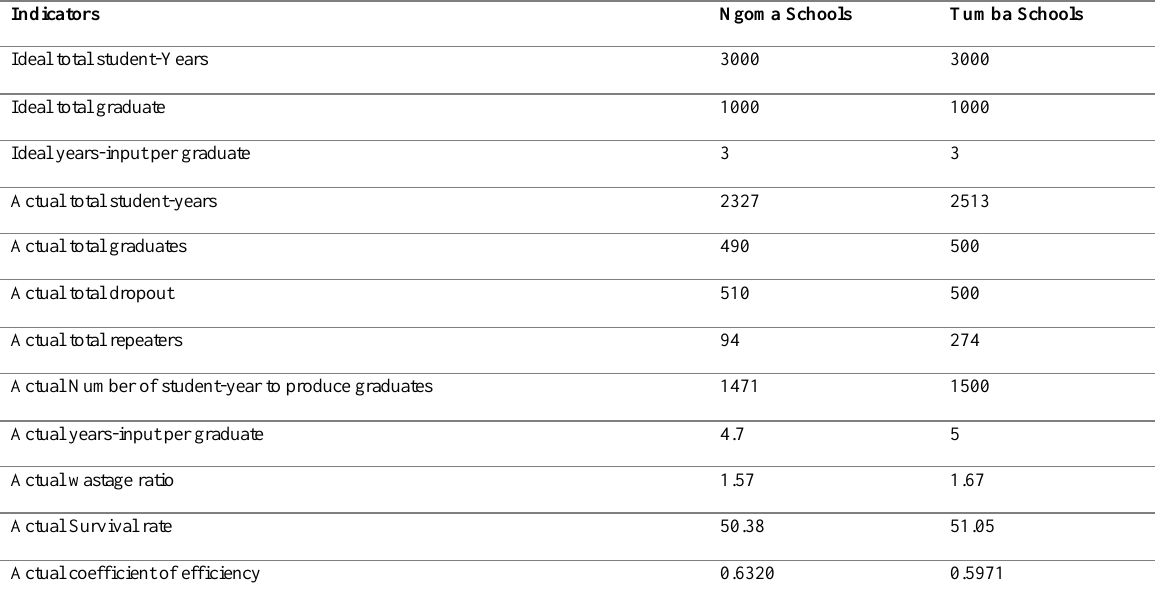
Table 1 : Indicators of internal efficiency for the cohort